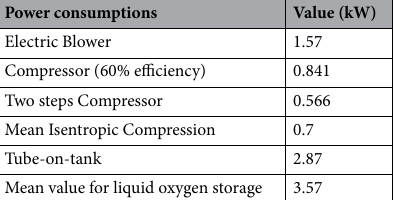
Table 5. Power consumption of the POP system various units to produce 2.25 kg/h O 2